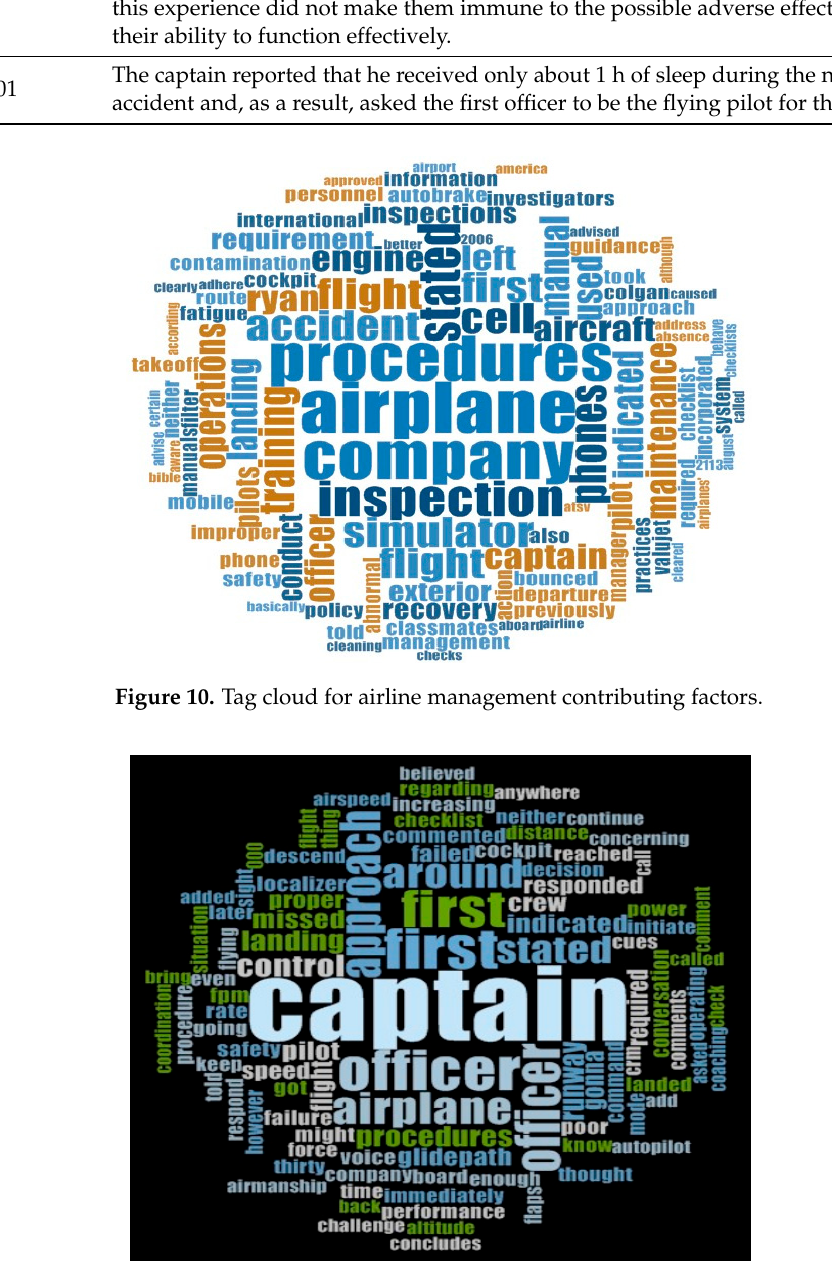
Figure 11. Word frequency tag cloud for CRM issues.